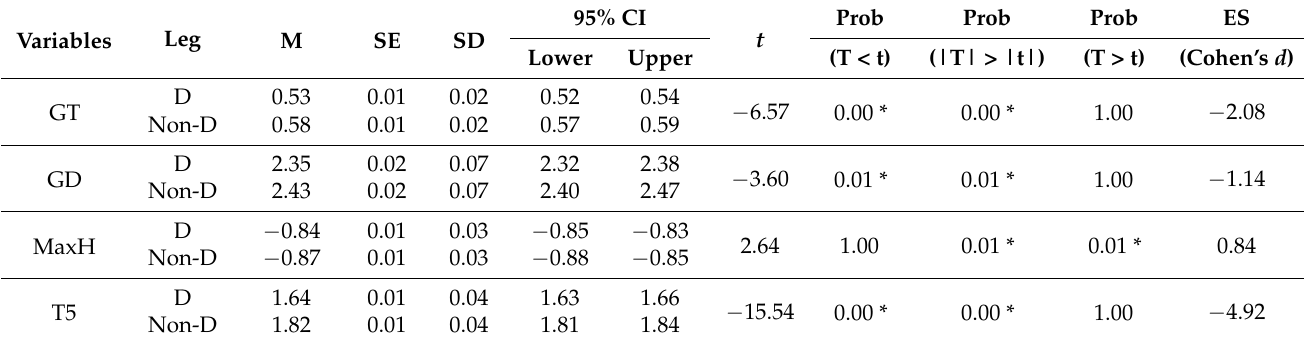
Table 4. Effects of leg dominance on kick-start parameters—underwater phase.